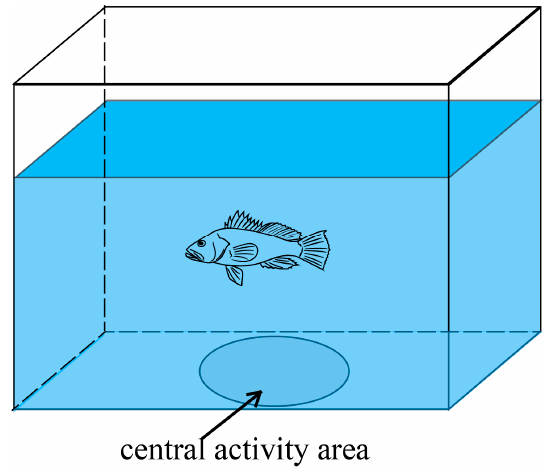
Figure 1. Device used to assess the boldness of black rockfish ( Sebastes schlegelii Hilgendorf, 1880). The white circle area at the bottom of the device is the central activity area.